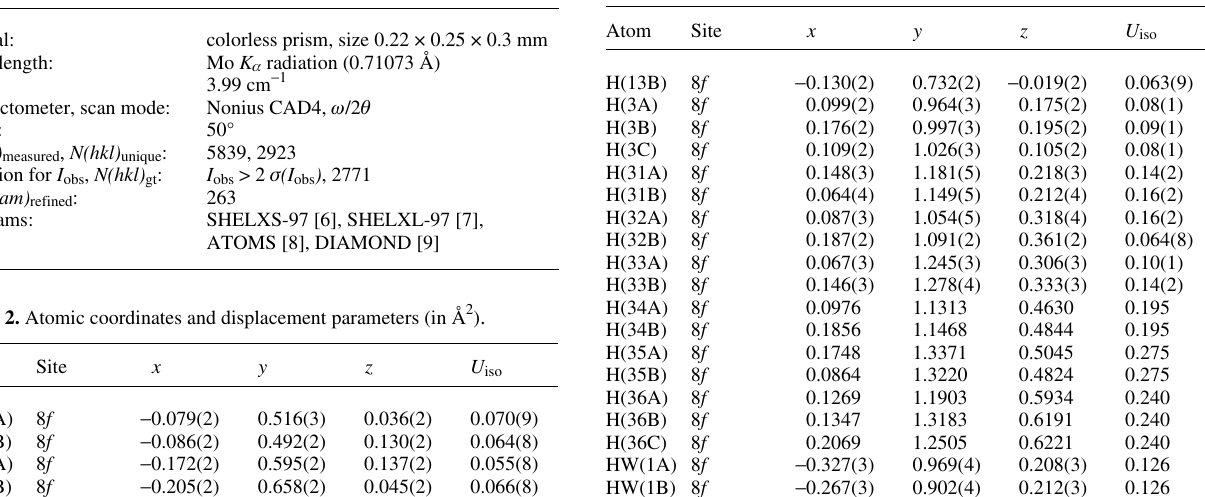
Table 1. Data collection and